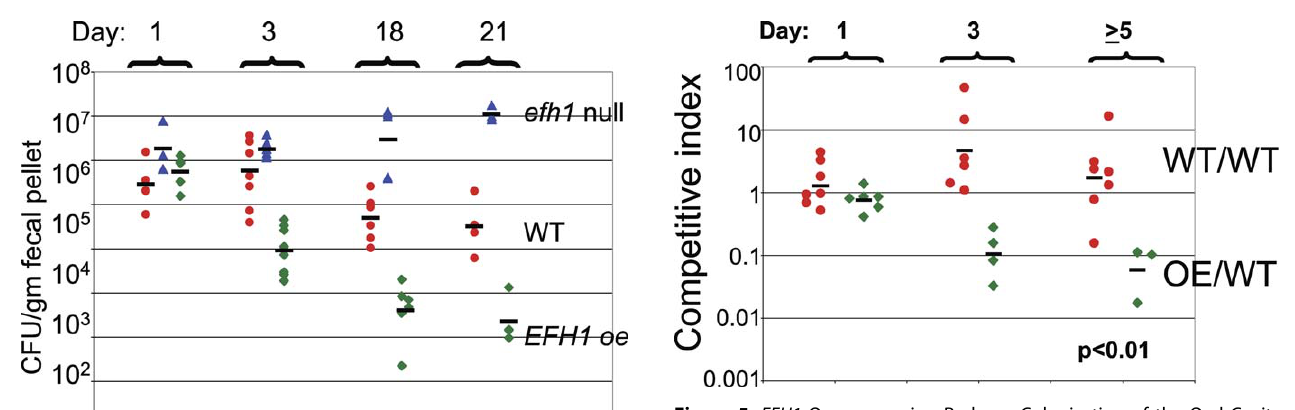
Figure 5. EFH1 Overexpression Reduces Colonization of the Oral Cavity in Immunodeficient Mice Cells of strains CKY363 (WT) or CKY364 ( EFH1 overexpressing, OE) were mixed in a 1:1 ratio with strain RMIS1 (Nou R marked WT) and introduced into the oral cavities of nude mice by swabbing. On various days post- inoculation, the oral cavities were sampled by swabbing. Swabs were rubbed on YPD SA plates and the colonies were replica-plated to YPSnourseothricin to determine the ratio of Nou S to Nou R colonies. The CI is defined as the ratio of Nou S /Nou R colonies at time x, divided by their ratio in the inoculum. Each symbol represents a sample taken from an individual animal. Composite results of two experiments are shown. Red circles, CKY363 (WT) mixed with RMIS1 (seven mice); dark green diamonds, CKY364 ( EFH1 overexpressing) mixed with RMIS1 (six mice). Day (cid:3) 5 includes samples taken at either day 5 or day 6. Samples that yielded very few colonies ( , 10) were not included on the graph. A statistically significant difference ( p , 0.01 by t test) was observed at day (cid:3) 5.